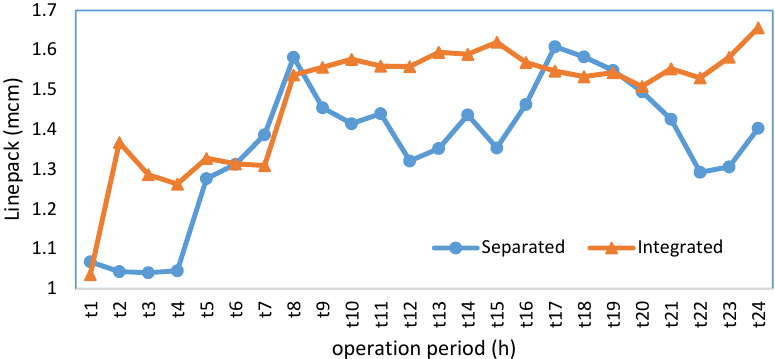
Figure 4. Aggregated linepack in the gas pipes in integrated and separated methods.